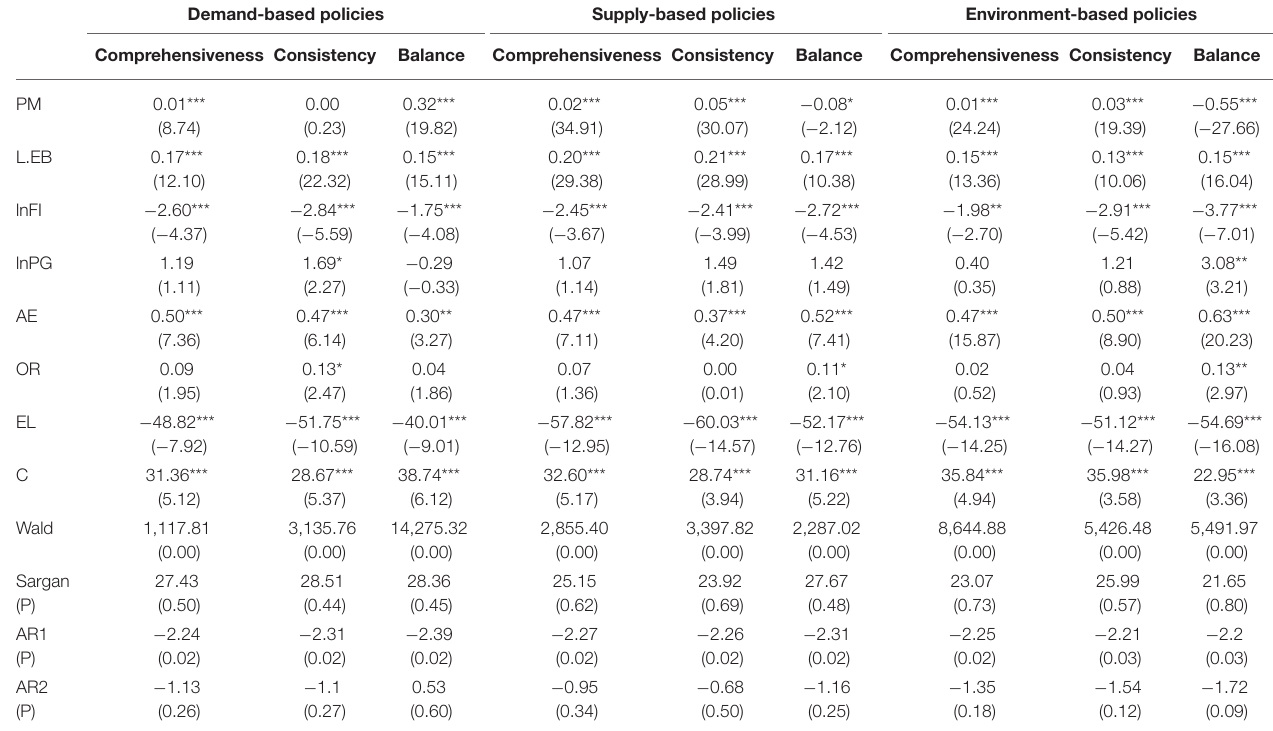
TABLE 4 | The impact of same-type policy instrument mix on the facility input of care institutions for older